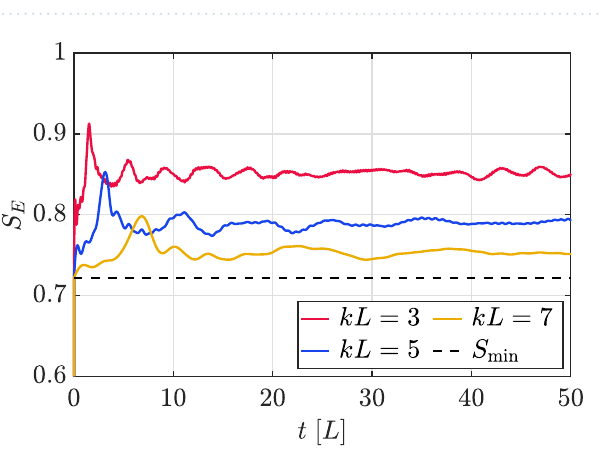
Figure 6. Probability distributions of the FPDs along the extra dimension y , for the value kL a histogram showing the value of the B n ( t ) coefficients, as defined by Eq. (48): see the text for an explanation. The left (right) panels show the left (right) FPD. The top panels are calculated at a shorter time t 1000 L . The initial condition is the same as in Fig. 5, and the simulation grid bottom ones at a longer time t = has 200 points along the y direction.